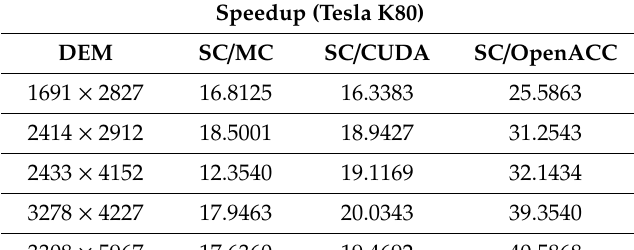
Table 9. Speedup (Tesla K80).